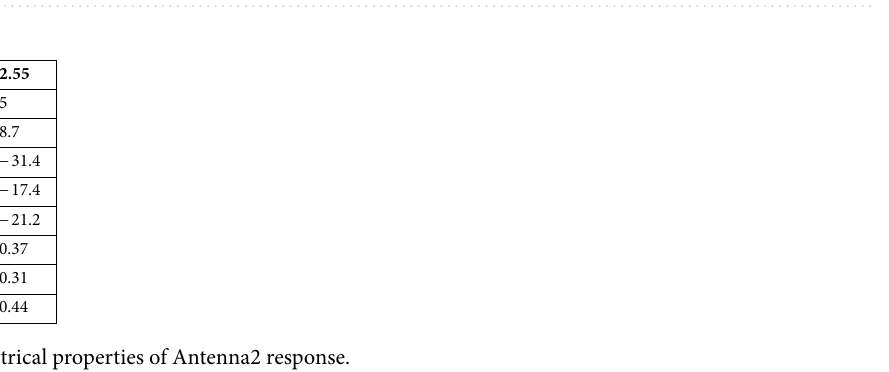
Figure 6. S11 response of Antenna2.